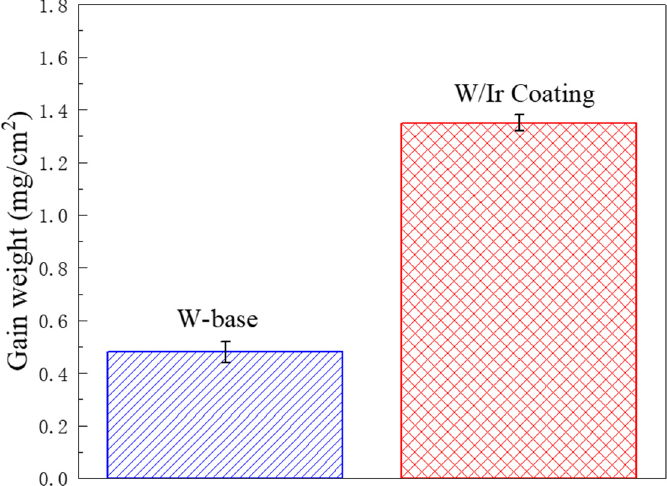
Figure 4. Appearance photos of the specimens after 1300 K + 8 h oxidation: ( a ) Tungsten substrate, ( b ) Iridium-coated tungsten.